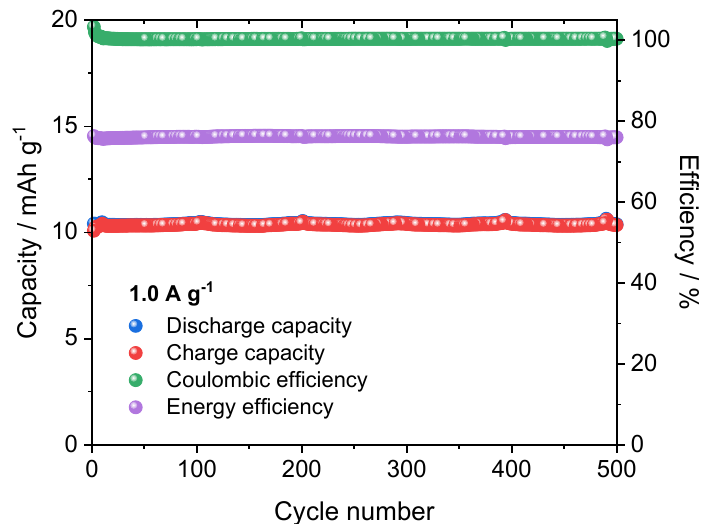
Figure A1. Long-term cycling of CXG 500 in AIB full-cell setup.